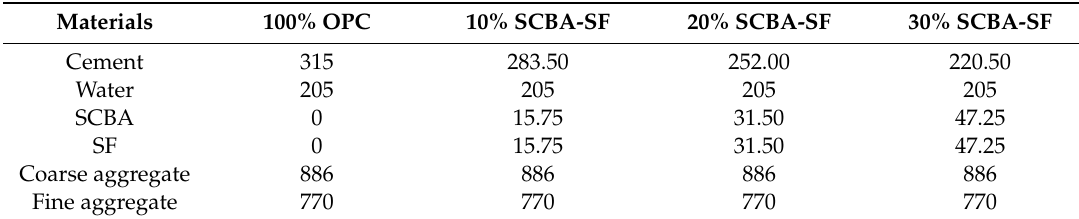
Table 2. Proportioning of concrete mixtures in kg for 1 m 3 of concrete (F´c = 29.4 MPa). OPC, ordinary